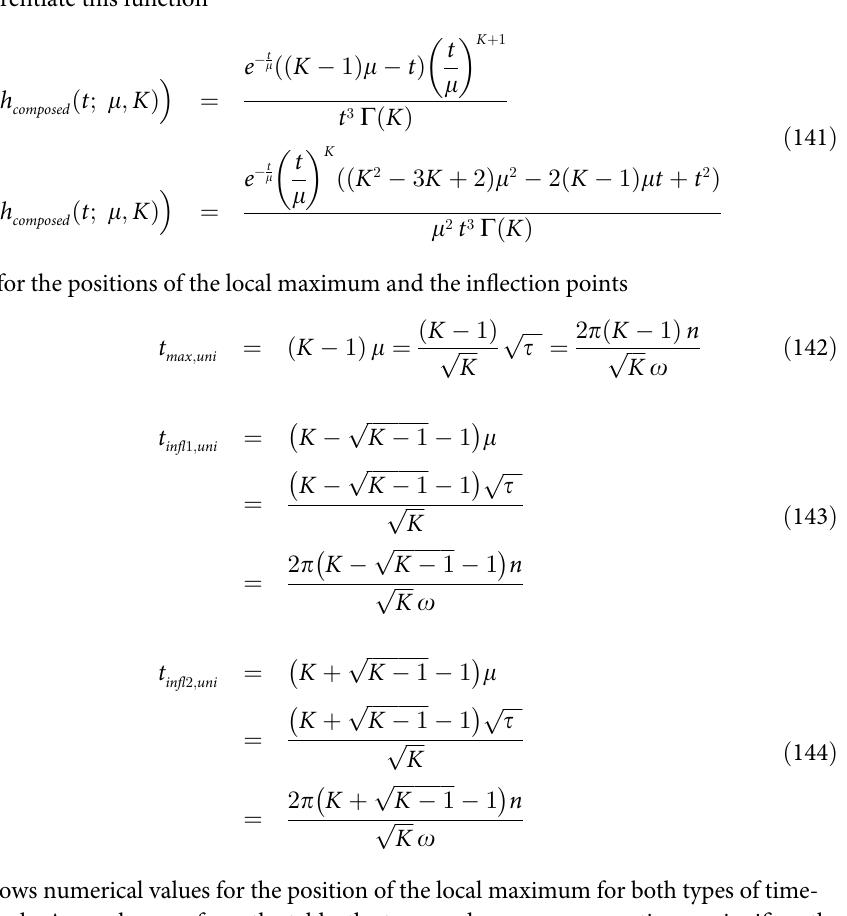
ffiffiffiffi p t for time-causal